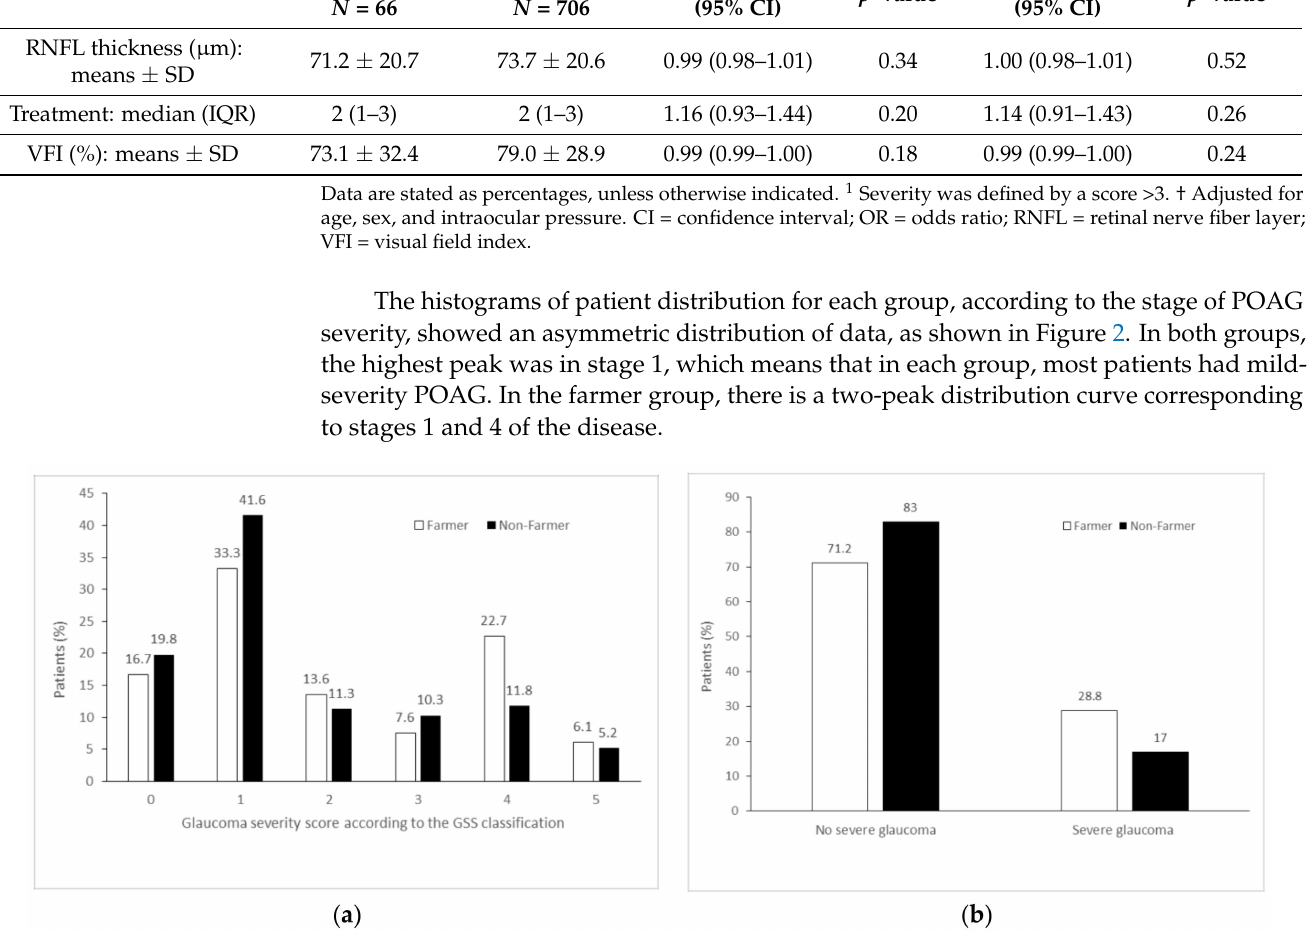
Figure 2. Distribution of the glaucoma severity score is displayed ( a ) according to the proportion of severe glaucoma and ( b ) according to farmer and nonfarmer group. GSS = glaucoma staging system. Severe glaucoma is defined for a GSS score